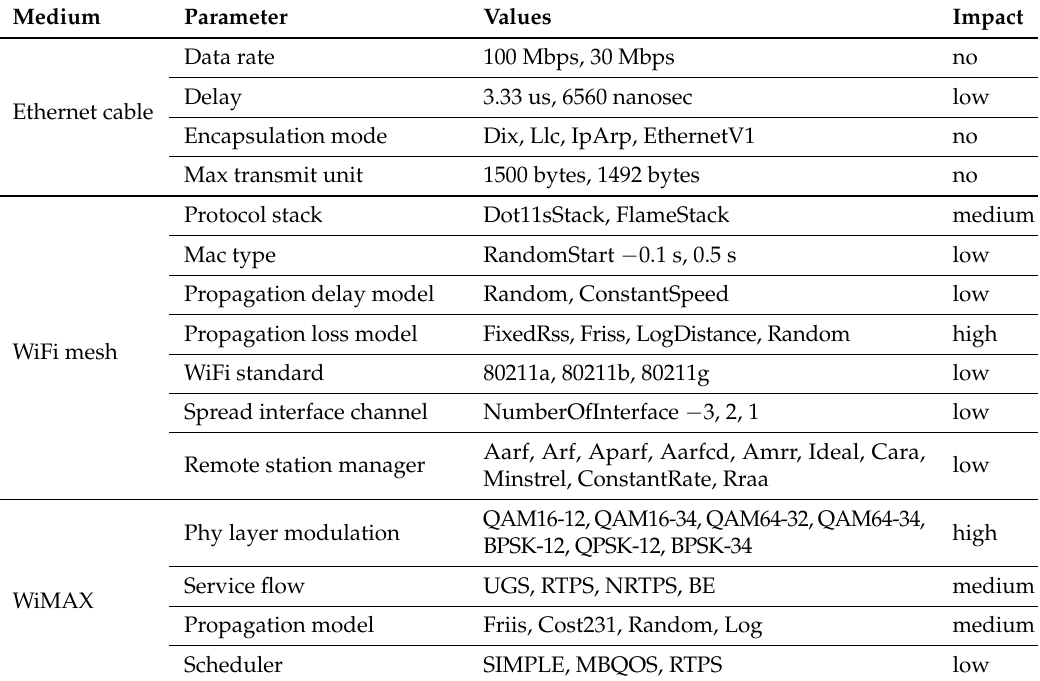
Table 3. Basic configuration and parameter verification of smart Meter-DC